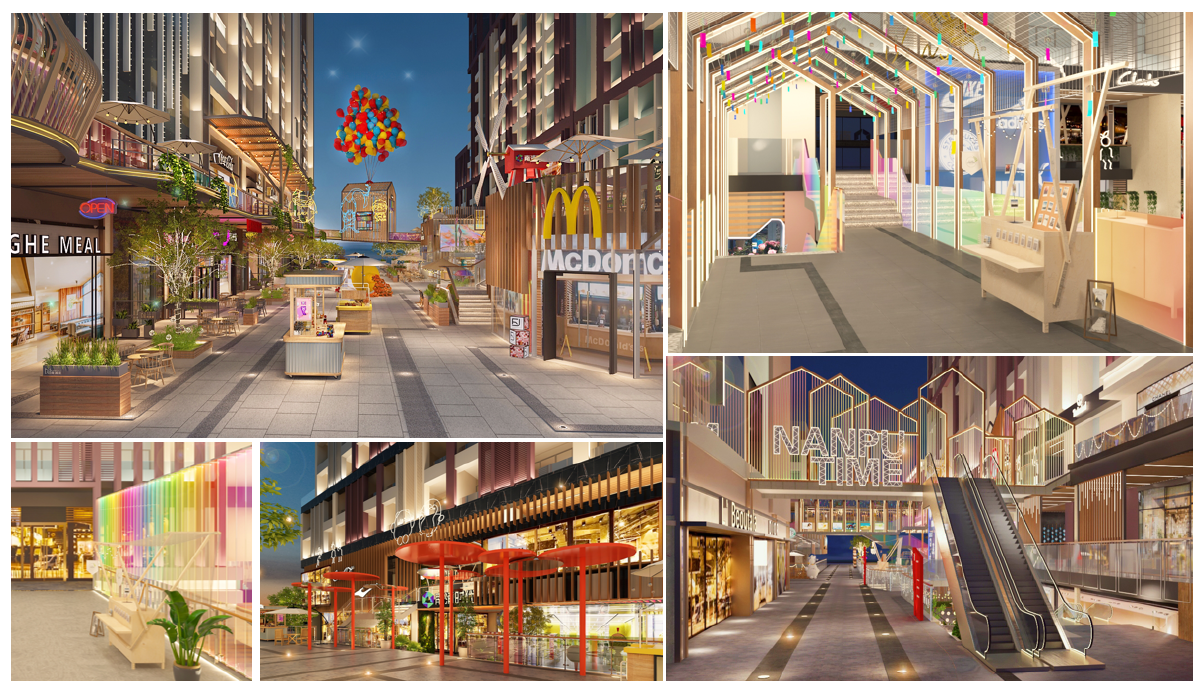
Figure 3. Partial design effect of Nanpu Times.